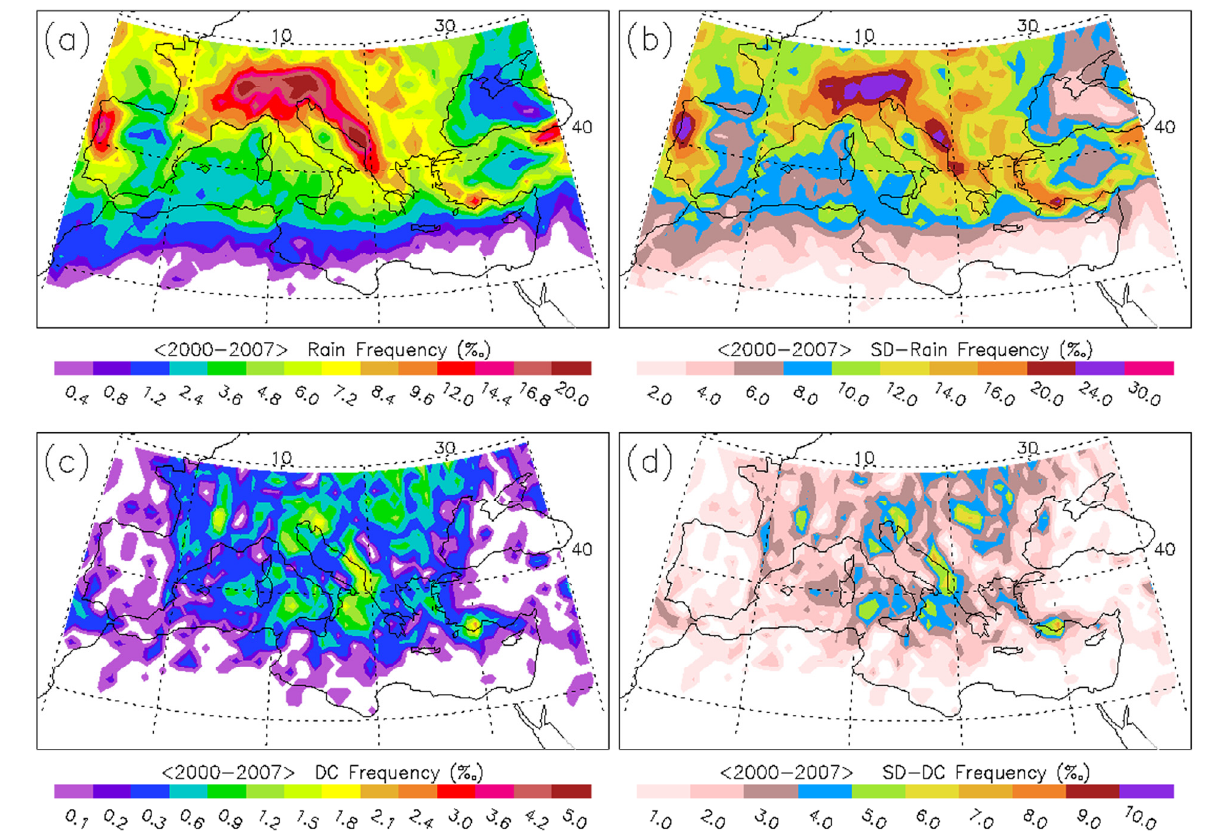
Figure 10. ERA-Interim climatologies (left) mean state and (right) interannual variability computed as standard deviation of the monthly means over the period 2000–2007 for a threshold of 30 mm/day. ( a , b ) rain frequency (‰) and ( c , d ) convective rain frequency